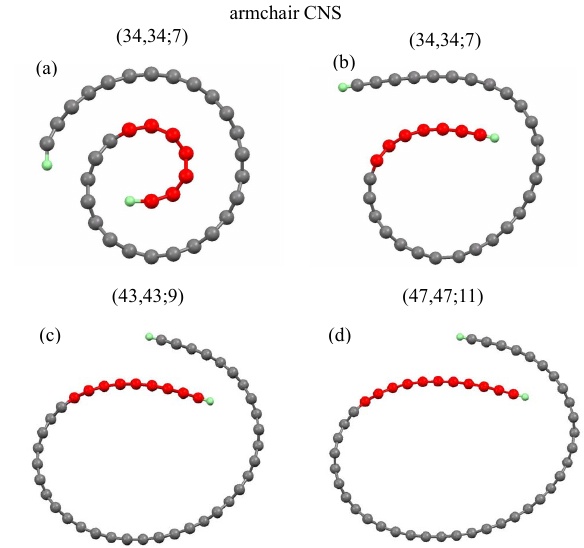
Figure 1. For armchair carbon nanoscrolls: the ideal structure of ( a ) ( 34,34;7 ) and the optimal structures of ( b ) ( 34,34;7 ) , ( c ) ( 43,43;9 ) ; ( d ) ( 47,47;11 ) . The ribbon width (N y ) is characterized by the number of dimer or zigzag lines along the transverse, and the internal length (N in ) only counts the dimer or zigzag lines in the internal lengths (red balls). Armchair and zigzag CNSs, with their geometric characteristics, are defined by (N y ,N y ;N in ) and (N y ,0;N in ),